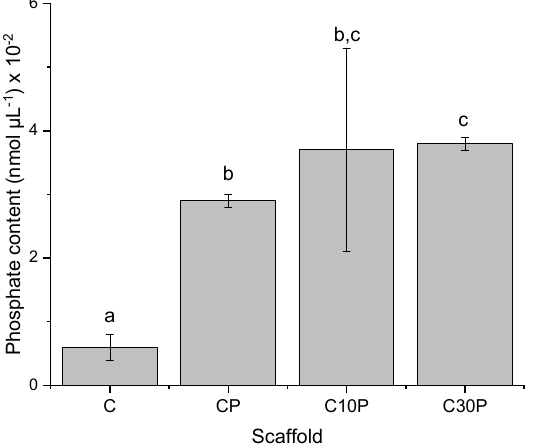
Figure 2. Quantitative comparison of phosphorous contents in phosphorylated scaffolds. (Same letter in the graphs means no significant difference; significance level of 5%).